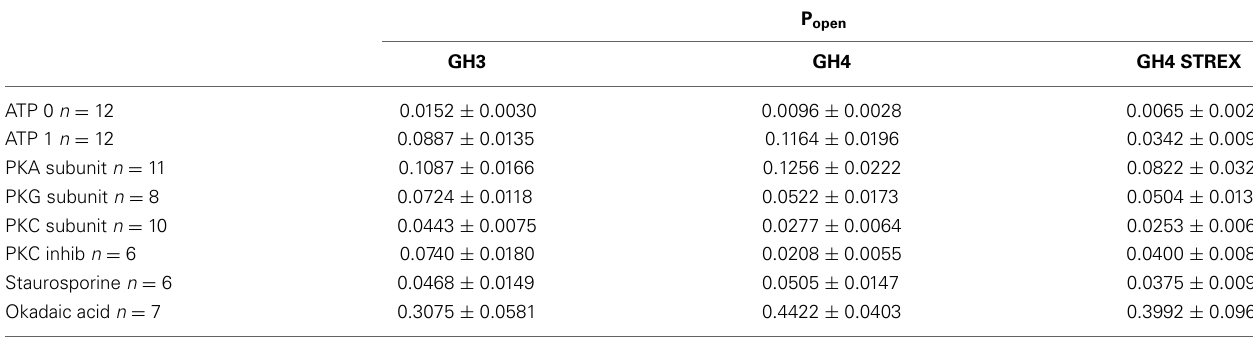
Table 2 | Phosphorylation of BK